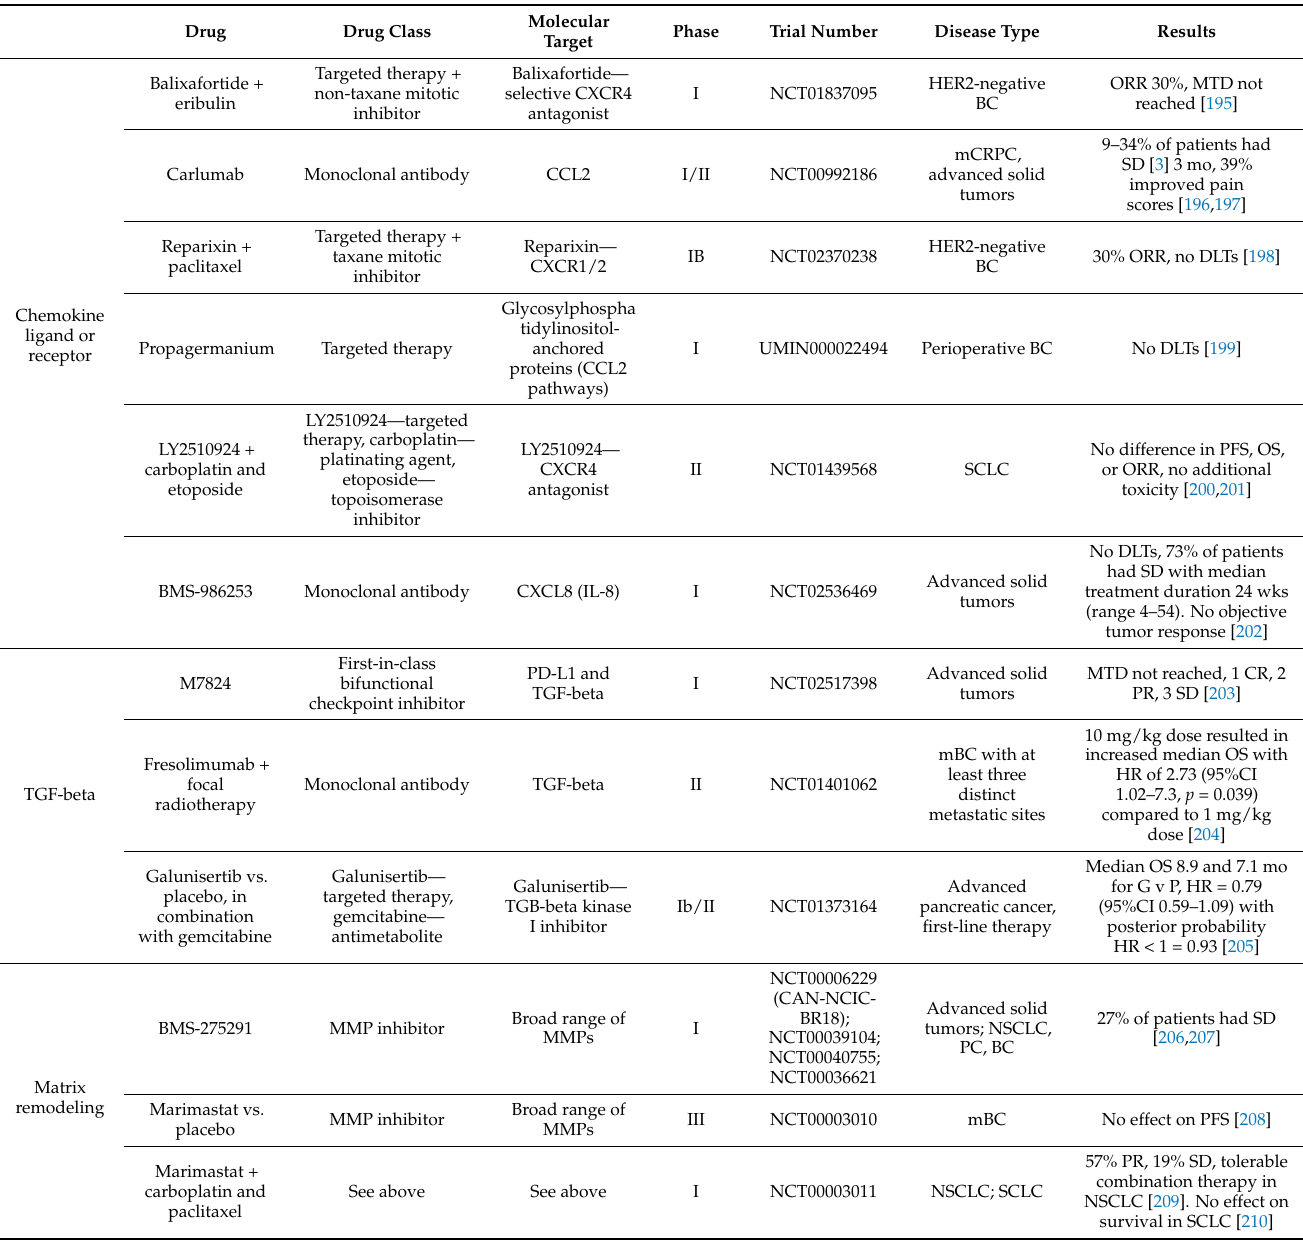
Table 2. Status of select clinical trials targeting bone metastasis pathways. ORR overall response rate, DLT dose limiting toxicity, MTD maximum tolerated dose, CR complete response, PR partial response, SD stable disease, PFS progression free survival, OS overall survival, CBR clinical benefit rate (PR rate+ rate of SD at least 6 months), BC breast cancer, mCRPC metastatic castrate